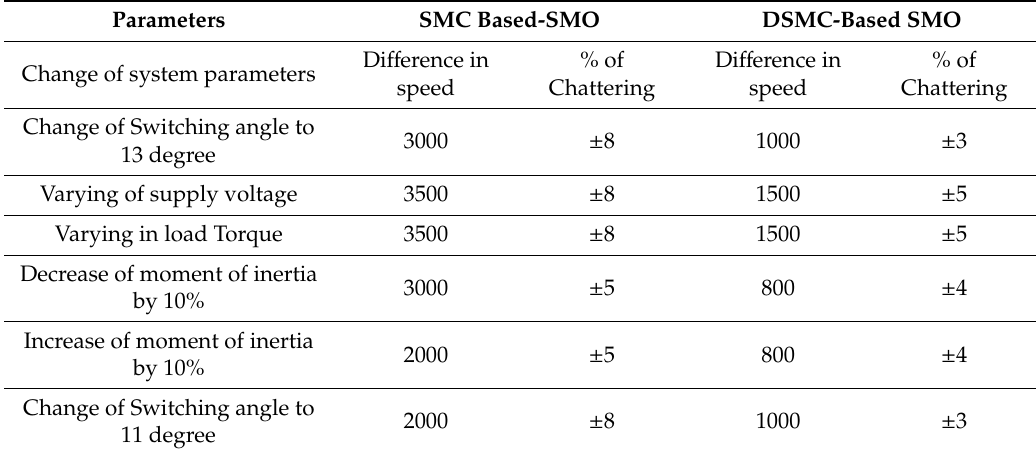
Table 4. Comparisons of speeds between the proposed and conventional methods.